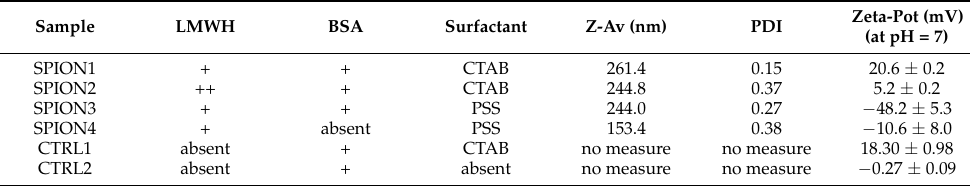
Table 1. Z-Av and Z-Pot measurements of SPIONs *.